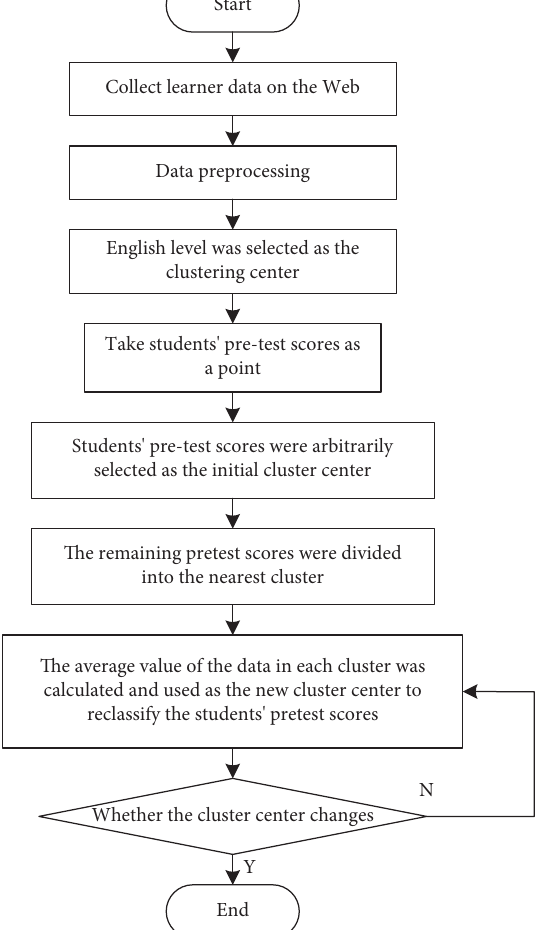
Figure 4: Flowchart of K -means